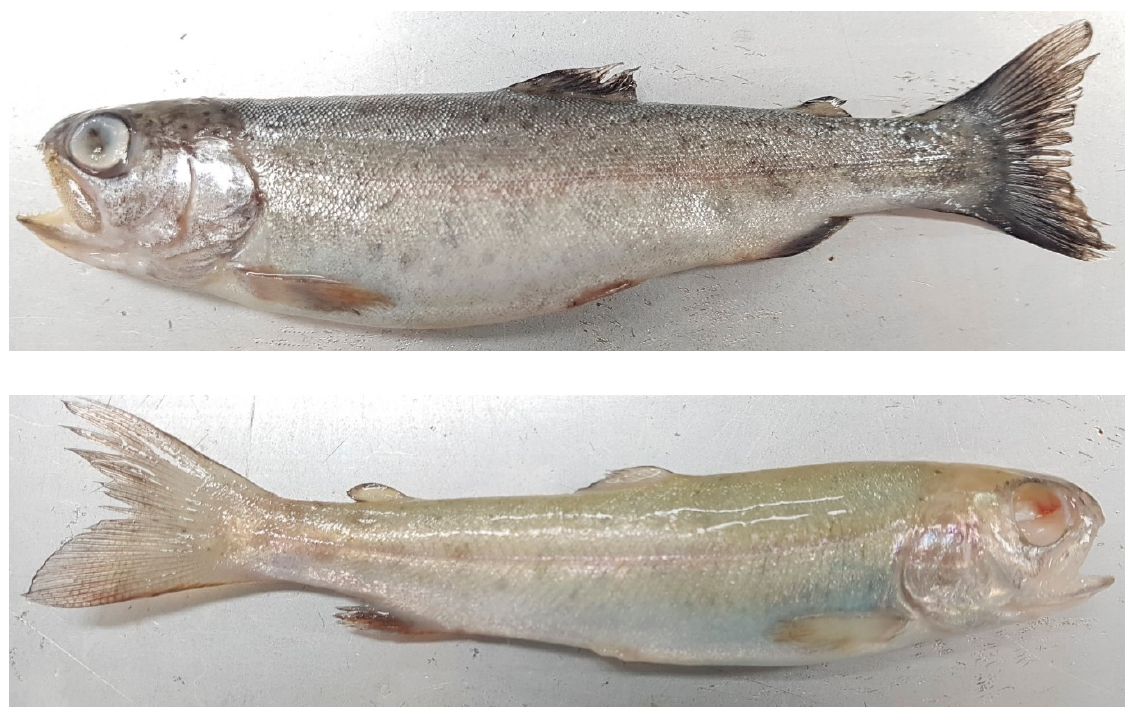
Figure 1. Clinical symptoms of keratitis and exophthalmia observed in S. xylosus- infected fish.